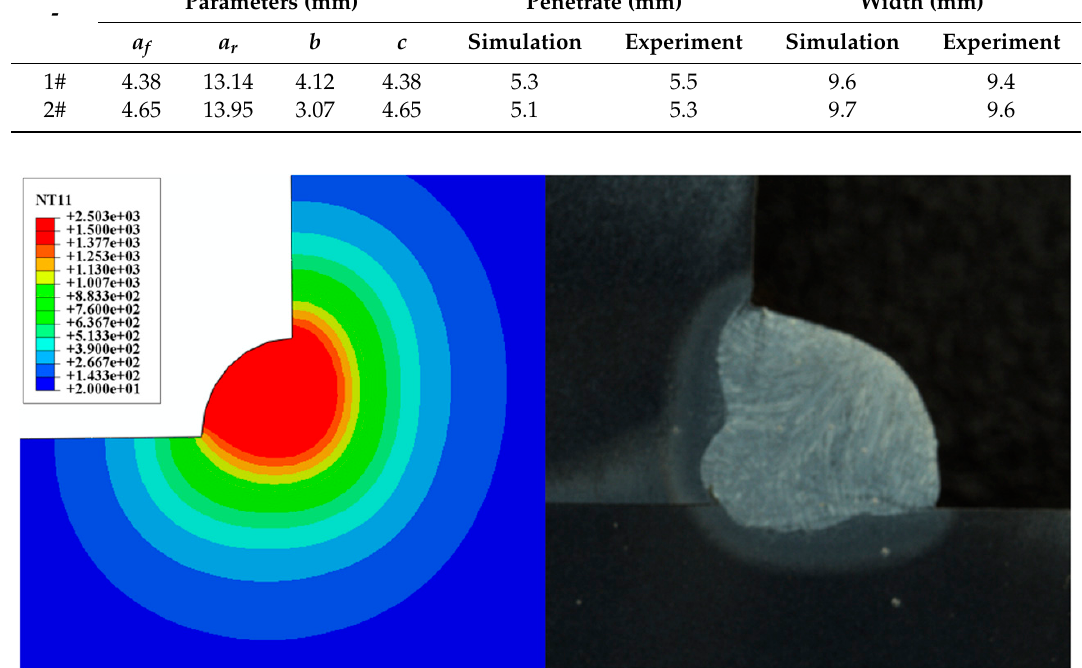
Figure 7. Comparison among calculated results and experimental results (Sample 2#).